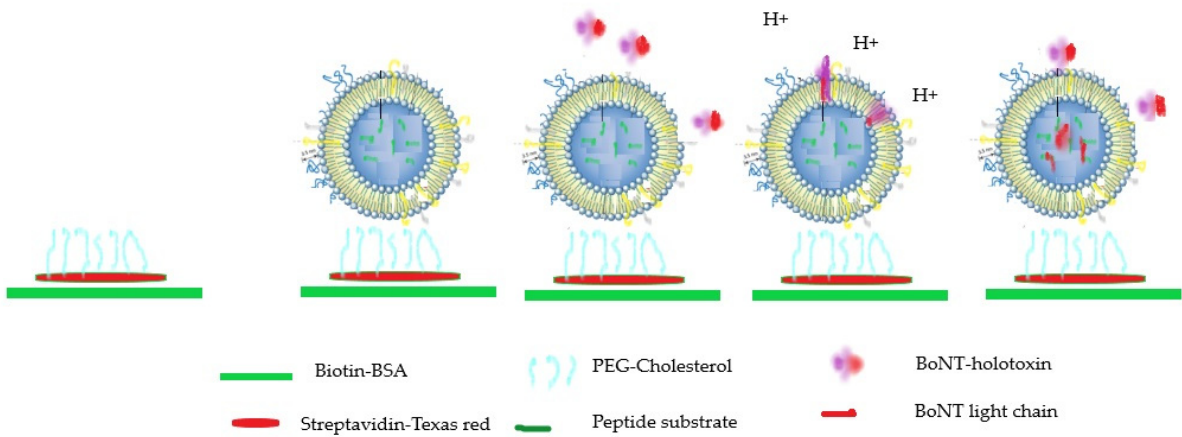
Figure 2. Sequential steps of microfluidic liposome immobilization and toxin detection. Surface modifications allow immobilization of NMN on the surface of the microfluidic channel. Botulinum neurotoxin is drawn through the channel and binds to the receptors on the liposomal membrane. Addition of the low pH buffer to the channel induces conformational changes of the receptor-bound toxin molecules and subsequent HC-mediated translocation of the LC into the liposome lumen. Inside the liposome lumen, LC proteolytically cleaves FRET peptide reporter molecules, which results in unquenching of the FRET pair and allows for fluorescent readout. The resulting increase in fluorescence intensity is directly influenced by the amount of physiologically active toxin molecules present in the original test solution, and therefore provides an estimate of its potency